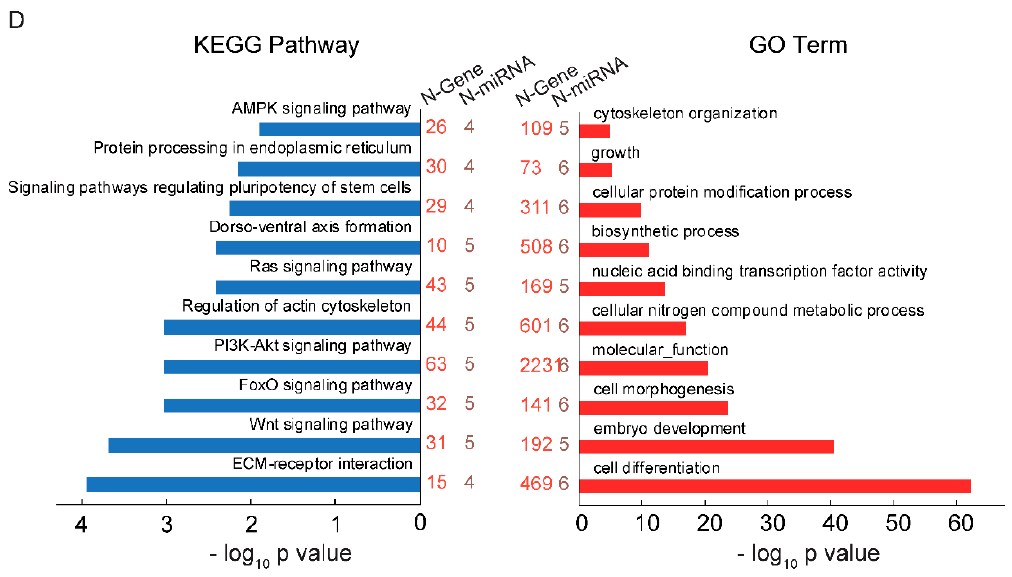
Figure 3. GAA modulates miRNA expression profile. Myoblasts were placed in DM with or without 20 mM GAA; 6 days later, total RNA was collected and small RNA-seq was carried out. ( A ) Venn diagram showing the numbers of overlapping and unique miRNAs detected in negative control and GAA-stimulated groups; ( B ) hierarchical clustering analysis for myotubes treated with GAA; NC-1 and NC-2 are two duplicates of the negative control; GAA-1 and GAA-2 are two duplicates of the GAA control; ( C ) the DE miRNAs that overlap between the negative control and GAA control; ( D ) GO (Gene Ontology) categories and KEGG (Kyoto Encyclopedia of Genes and Genomes) pathways enriched for target genes of DE miRNAs in myotubes (N-Gene: the number of genes enriched into indicated item, N-miRNA: the number of miRNA enriched into indicated item).